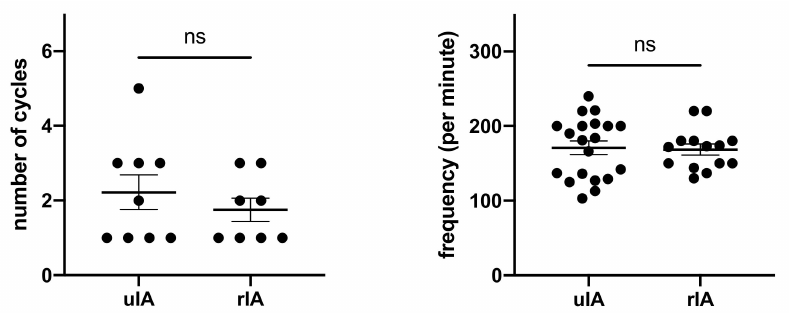
Figure 2. Amount of cycles and frequencies used for RVP were